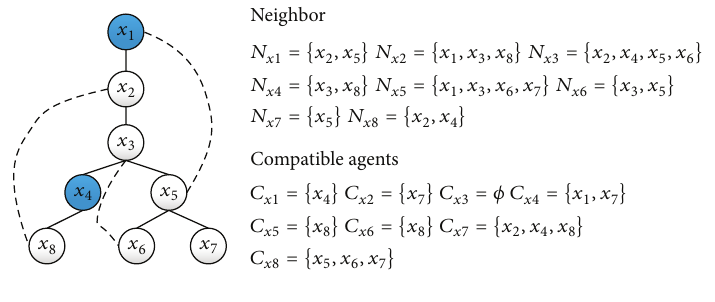
Figure 6: Parallelism based on a complex constraint